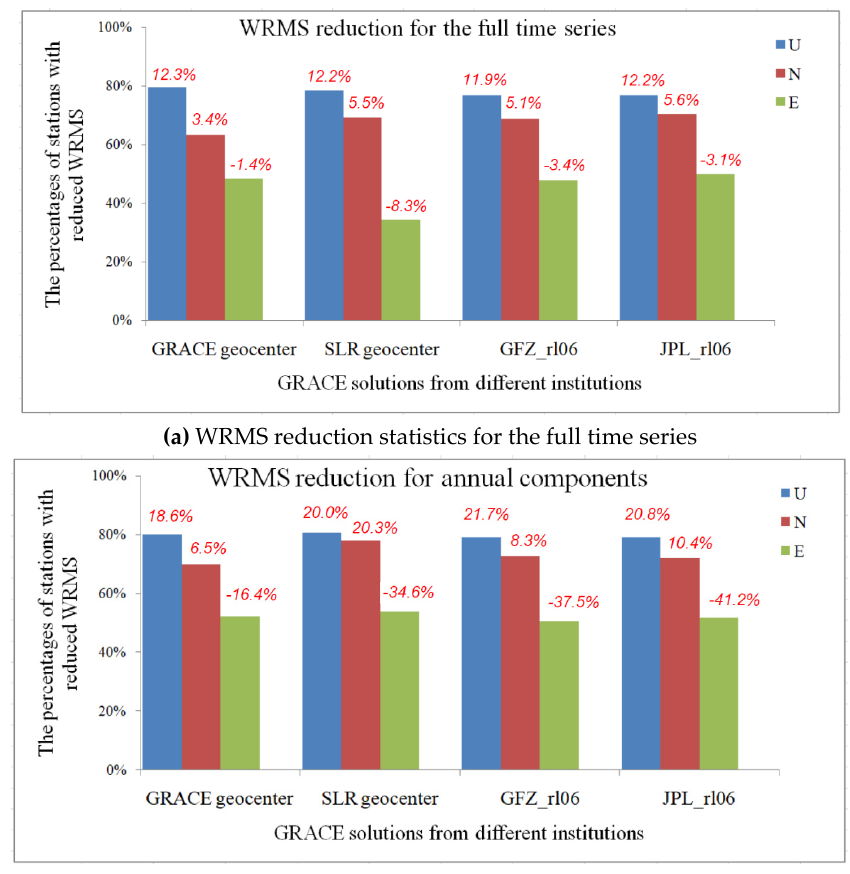
Figure 9. WRMS reductions obtained for the east, north and vertical components using GRACE- derived deformations corrections.